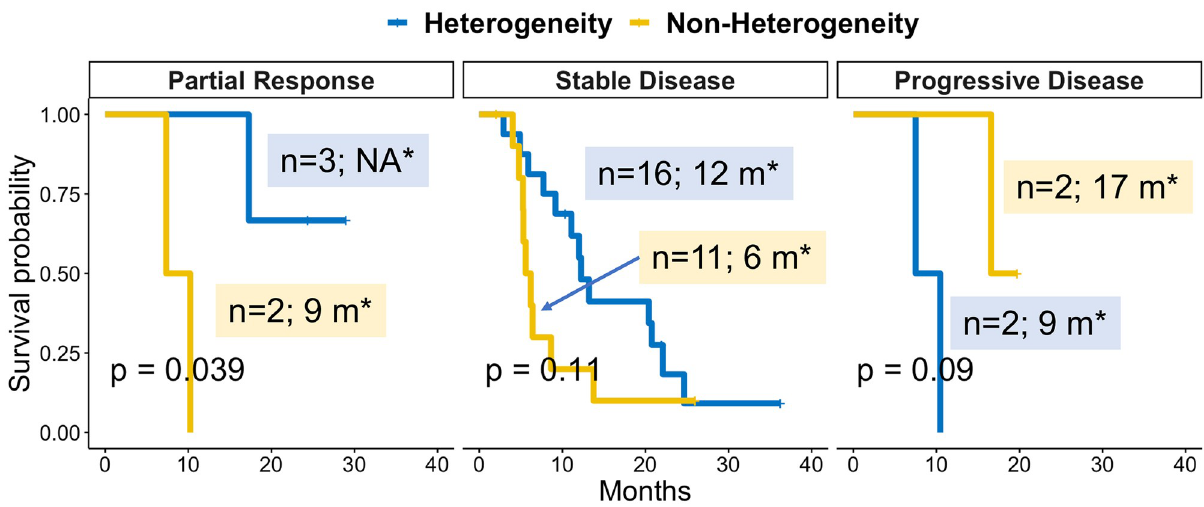
Fig 7. Survival analysis. � : median OS; m: